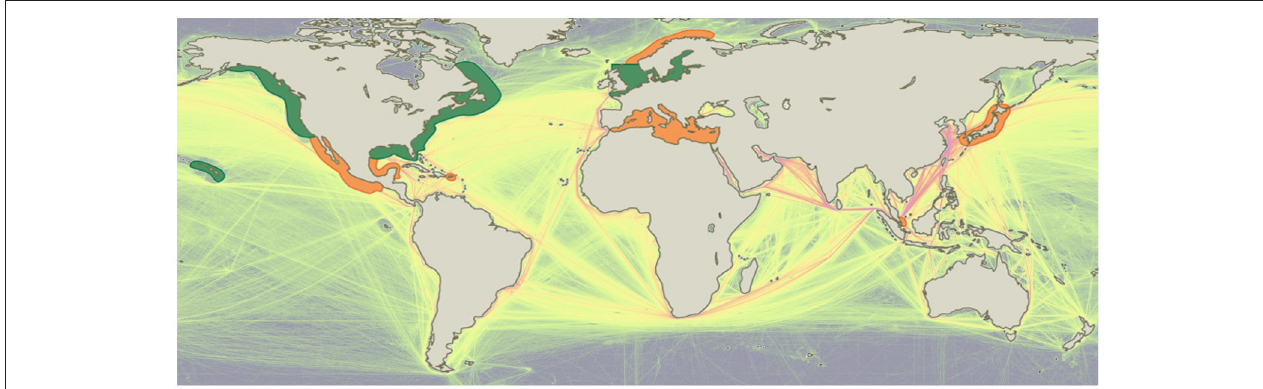
FIGURE 2 | Global shipping activities based on AIS data (data from Johansson et al., 2017) and locations of existing ECAs in green and possible ECAs in orange (map source: Exzellenzcluster Ozean der Zukunft International Ocean Institute,